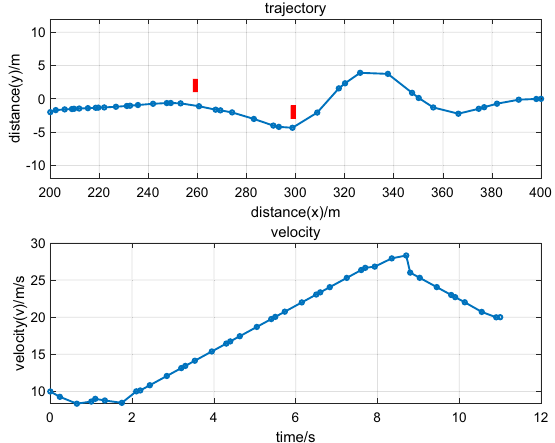
Figure 4. Trajectory optimization and driving state of the leading